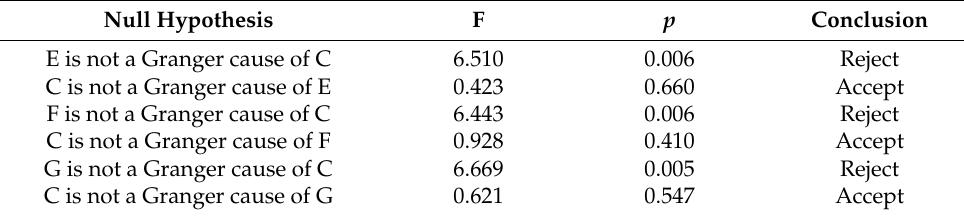
Table 6. Granger causality